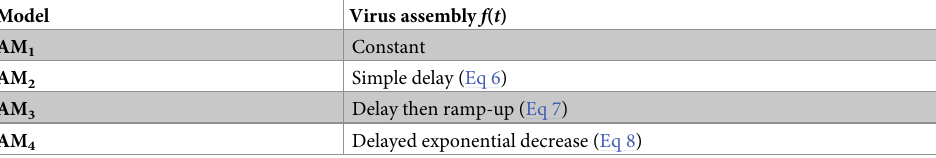
Table 2. Assembly model variants. Overview of the different virion assembly models